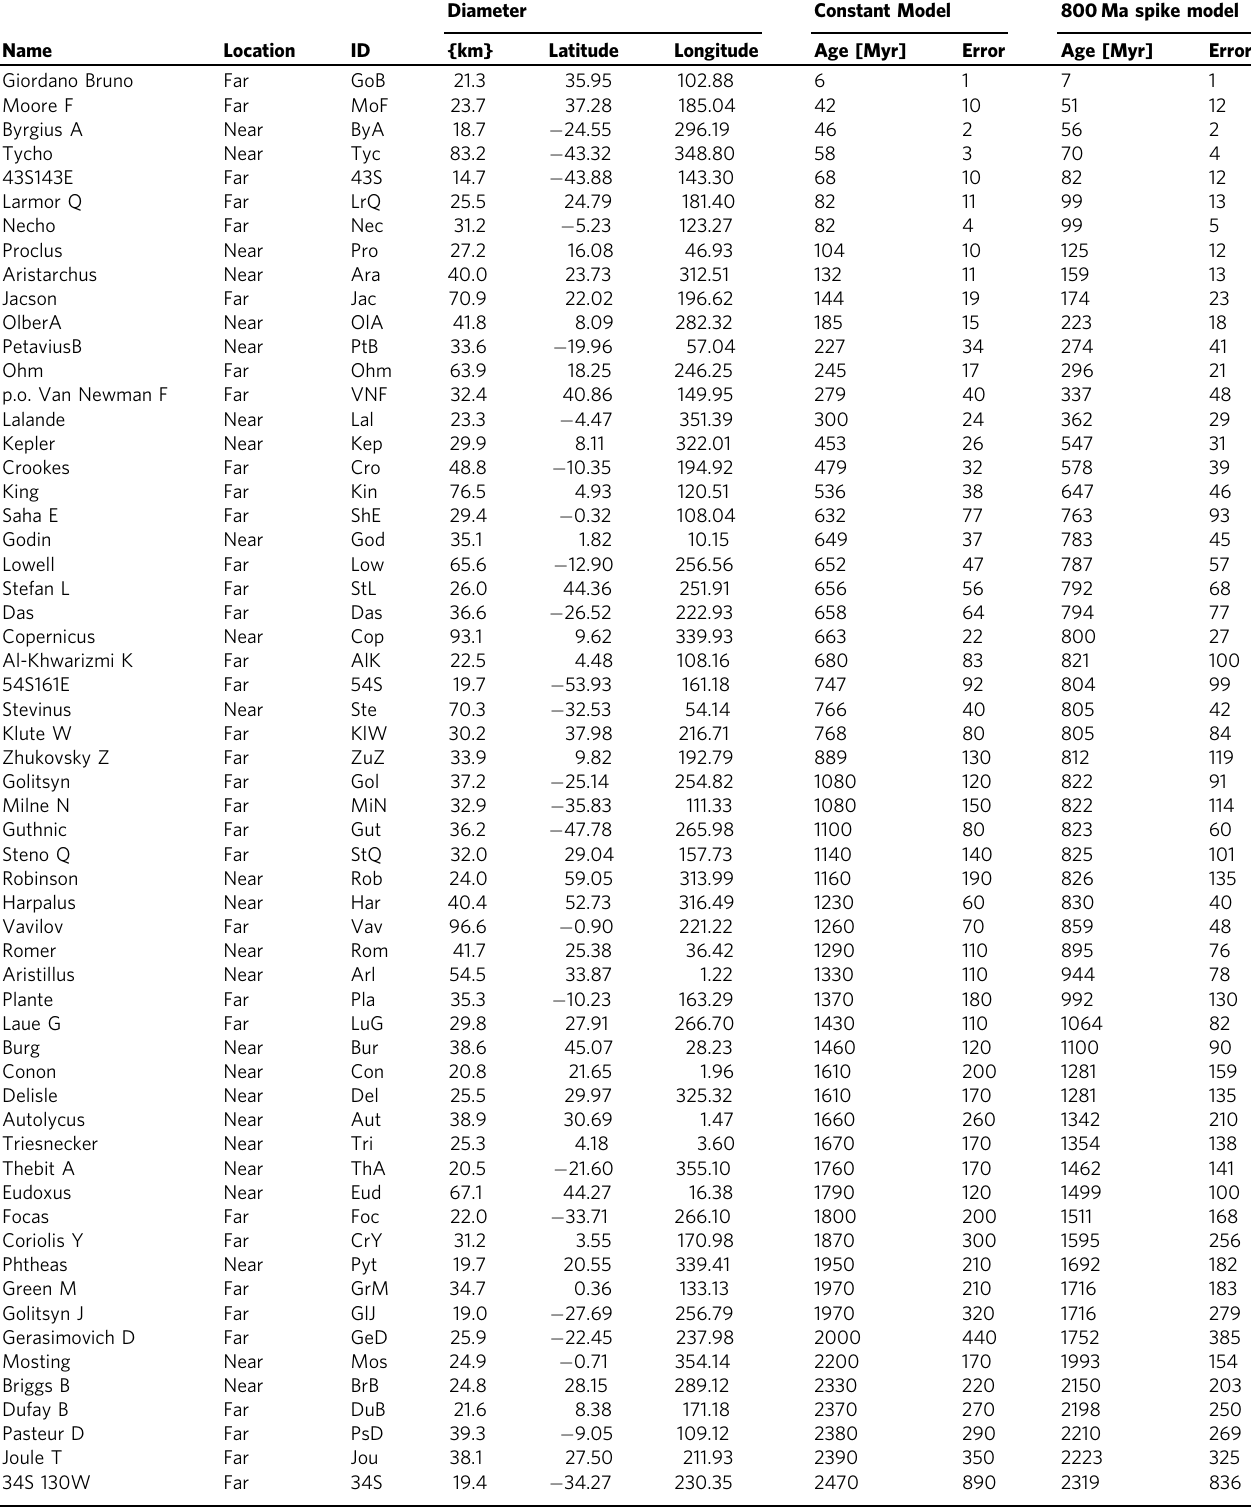
Table 1 Size. Location and model age of lunar craters (>~15 km) with fresh